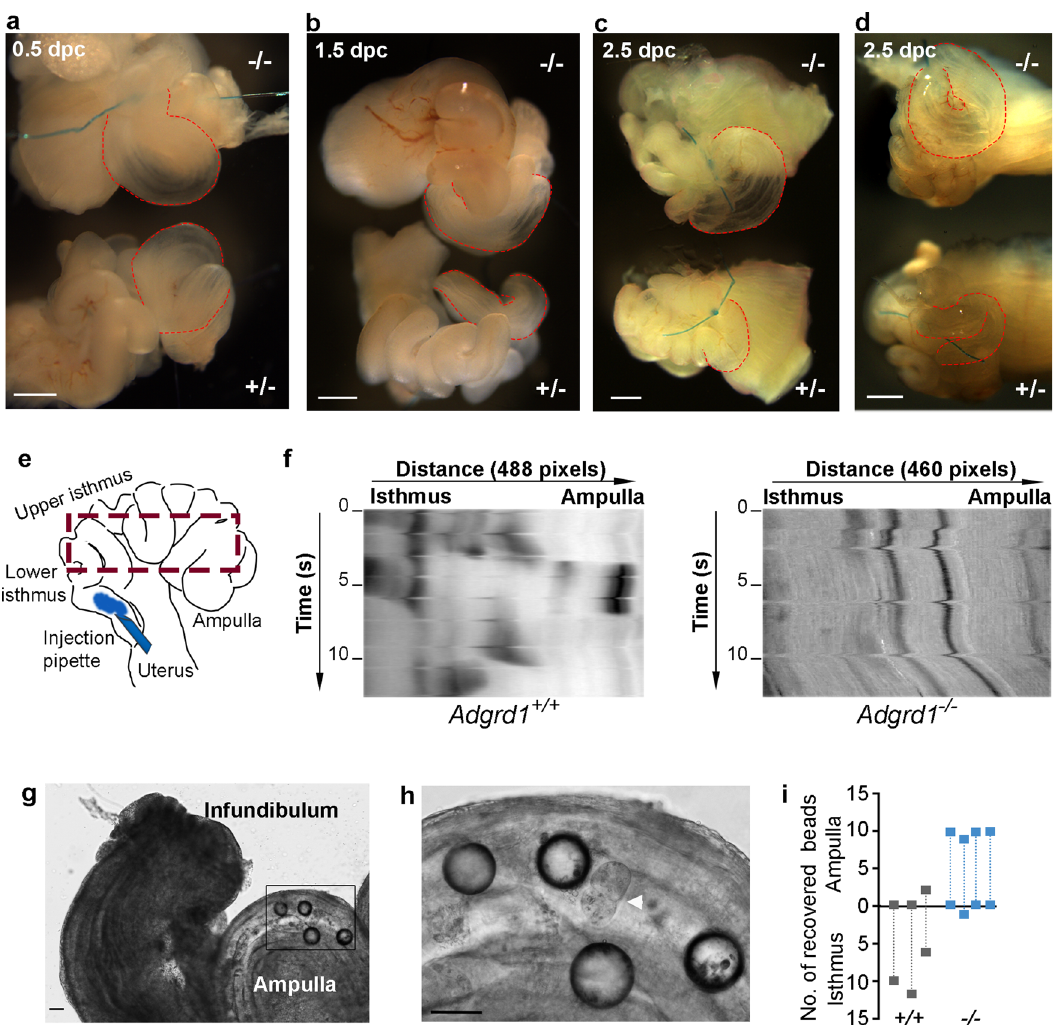
Fig. 4 Adgrd1 regulates post-ovulatory attenuation of oviductal fl uid production. a Accumulation of fl uid is comparable in ligated control ( + / − ) and mutant ( − / − ) oviductal explants in vitro at 0.5 dpc; ampullary distension is marked with red lines. b No reduction in fl uid accumulation in mutant Adgrd1 − / − oviducts at 1.5 dpc by contrast to heterozygous control. c Oviductal ligation at 2.5 dpc in vitro: more fl uid has accumulated in the ampulla of the mutant compared to control. d The ampulla of mutant ( − / − ) oviducts exhibited a more pronounced distension compared to heterozygous control ( + / − ) after in vivo ligated at 2.5 dpc and collected four hours later; the ampullary region is highlighted by dotted red lines. Images in a , b , c and d are representative of at least three independent experiments and the scale bar represents 500 μ m. e Schematic showing the region of the oviduct used for producing the kymographs. f Kymographs showing the behaviour of a tracer dye injected into the oviduct of Adgrd1-mutants compared to wild type littermate control. Adgrd1-mutant oviducts are rapidly fi lled with the dye which does not change over the time of observation whereas control oviducts segregate the dye into boluses which are gradually moved towards the ampulla. g Glass beads (~100 μ m diameter) were inappropriately retained in the ampulla of Adgrd1 − / − oviducts. Image taken 24 h after bead transplantation. h Magni fi cation of the boxed area in g , showing glass beads and retained embryo (arrowhead). Scale bars represent 80 μ m, images are representative of four independent experiments. i Distribution of 10 to 12 transplanted glass beads in Adgrd1 − / − ( n = 4) and control ( n = 3) oviducts at 1.5